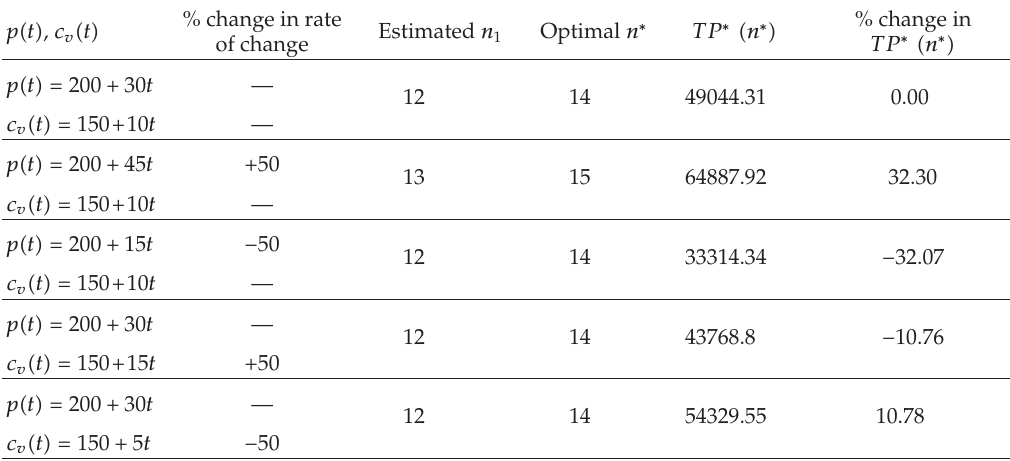
Table 4: Sensitivity analysis on rate of change for Example